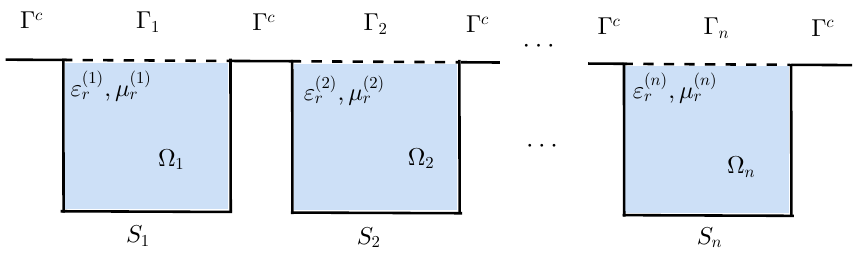
Figure 2. The geometric model of the finite array of